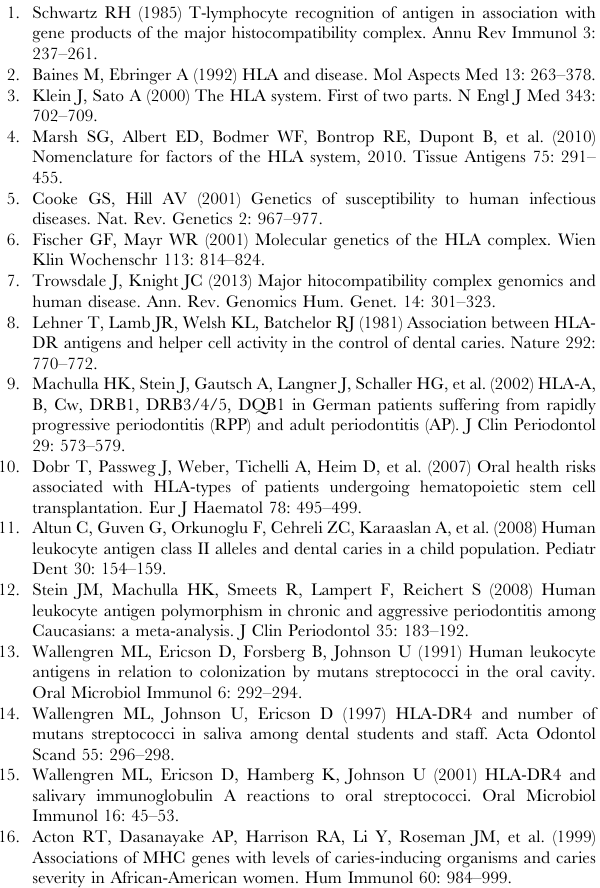
Table S1 Descriptives of the subjects according to HLA-A, -B and -DRB1 types. Table S2 Original